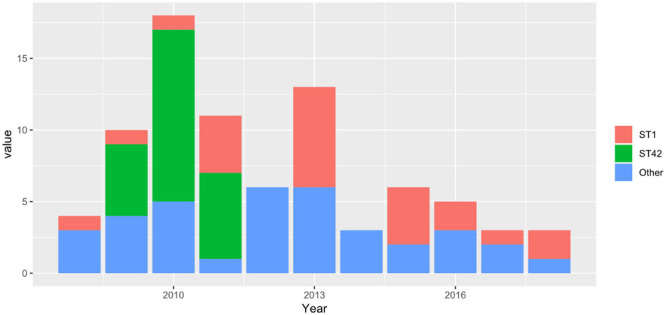
Stacked barplots, representing the number of STs in a first-time infection occurrence in a given year.